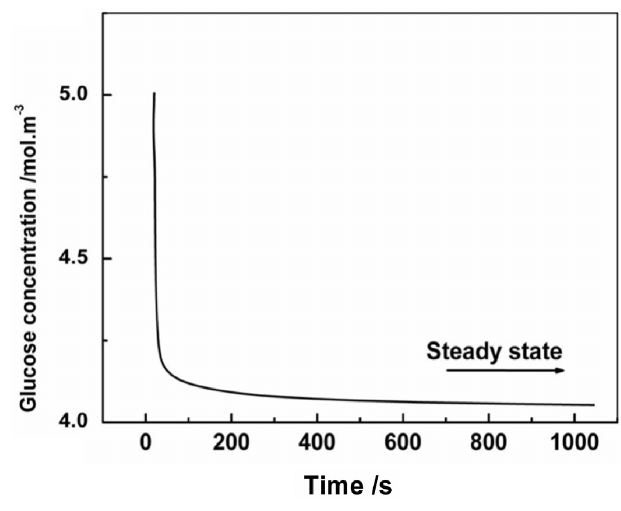
Figure 2. Response time to reach steady state for electrode at height of 200 µm with well width of 100